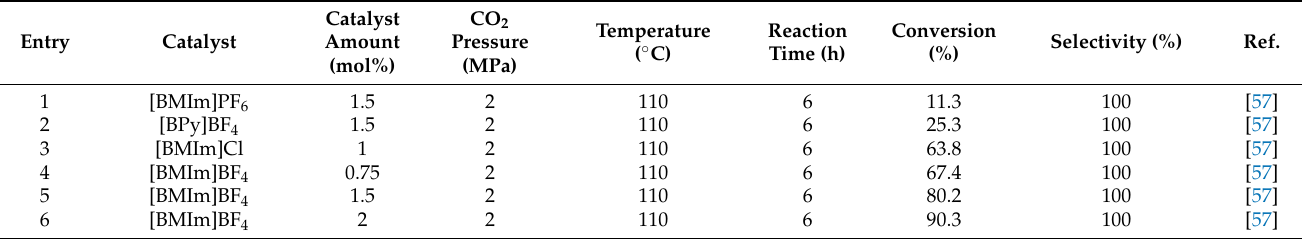
Table 9. Effect of the ionic liquid structure on the cycloaddition reaction of